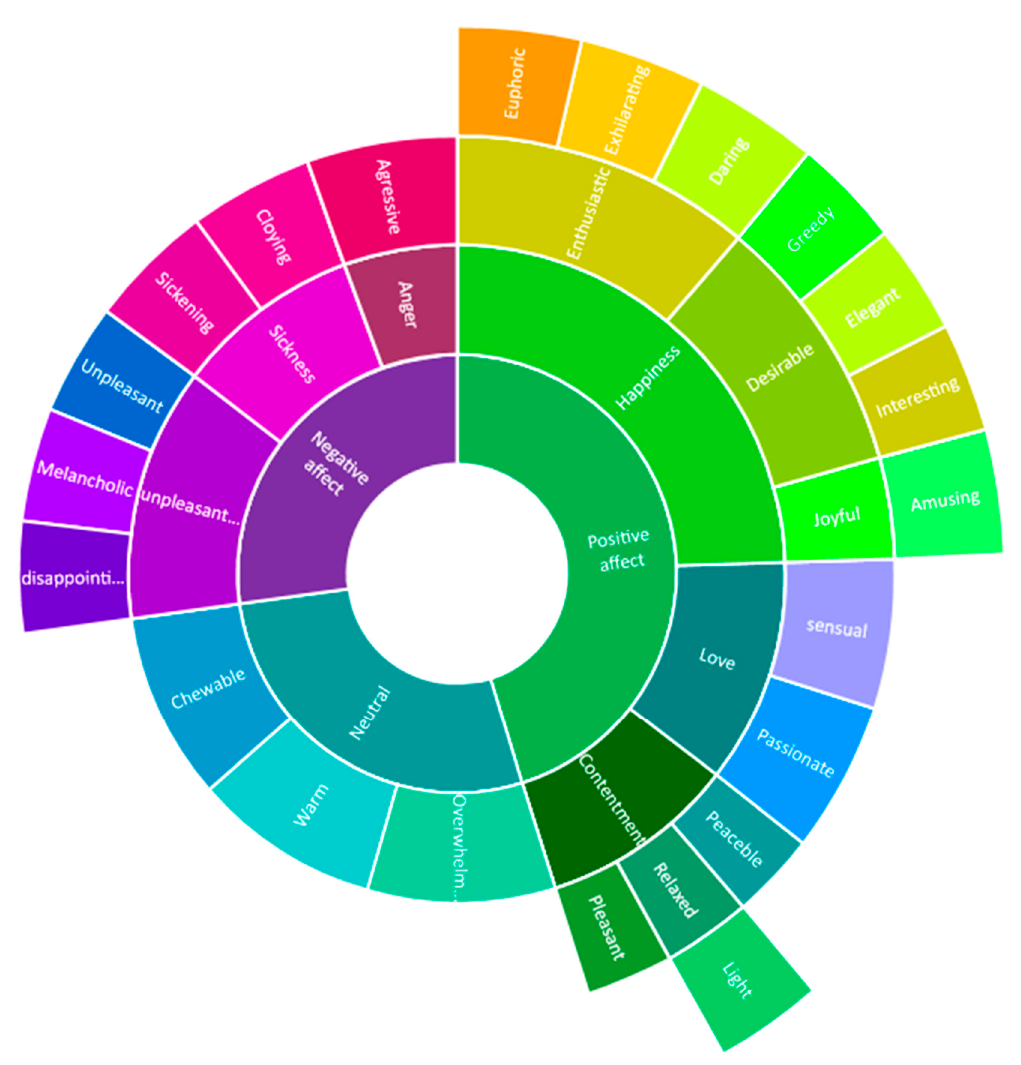
Figure 6. The wine taster’s emotion wheel.